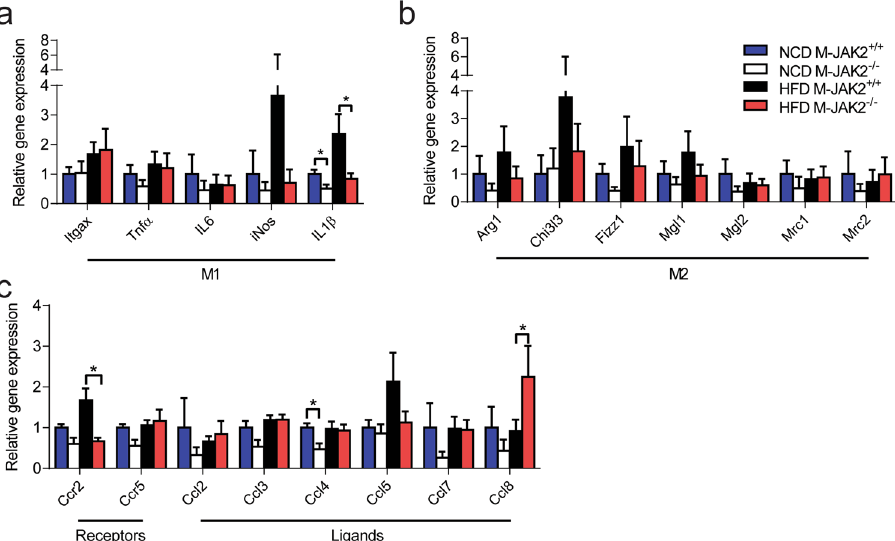
Figure 7. Cytokine measurements in peritoneal macrophages. mRNA expression as fold change over NCD-fed M-JAK2 + / + mice for ( a ) M1 markers, ( b ) M2 markers, and ( c ) chemokine receptors and its associated ligands in thioglycolate-elicited peritoneal macrophages from NCD (n = 3–4) or HFD (n = 5) fed M-JAK2 + / + and M-JAK2 − / − mice. All results are mean ± SEM; * p <